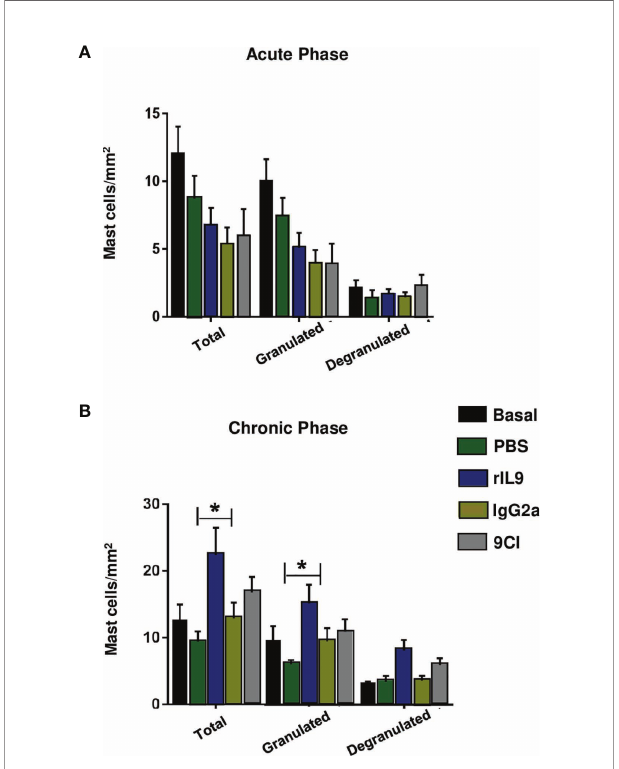
FIGURE 9 | rIL9 treatment increased the recruitment of total mast cells, mostly granulated mast cells, in cardiac tissue from Trypanosoma cruzi - infected mice after 60 dpi. Total numbers of mast cells, granulated mast cells, and degranulated mast cells were counted in cardiac tissue from T. cruzi - infected BALB/c mice, those treated with 9CI or rIL9, and the respective control mice (treated with IgG2a and PBS, respectively). The mice were euthanized after 15 dpi (acute phase) (A) and 60 dpi (chronic phase) (B) . Control: uninfected and untreated mice. Anova test *p <